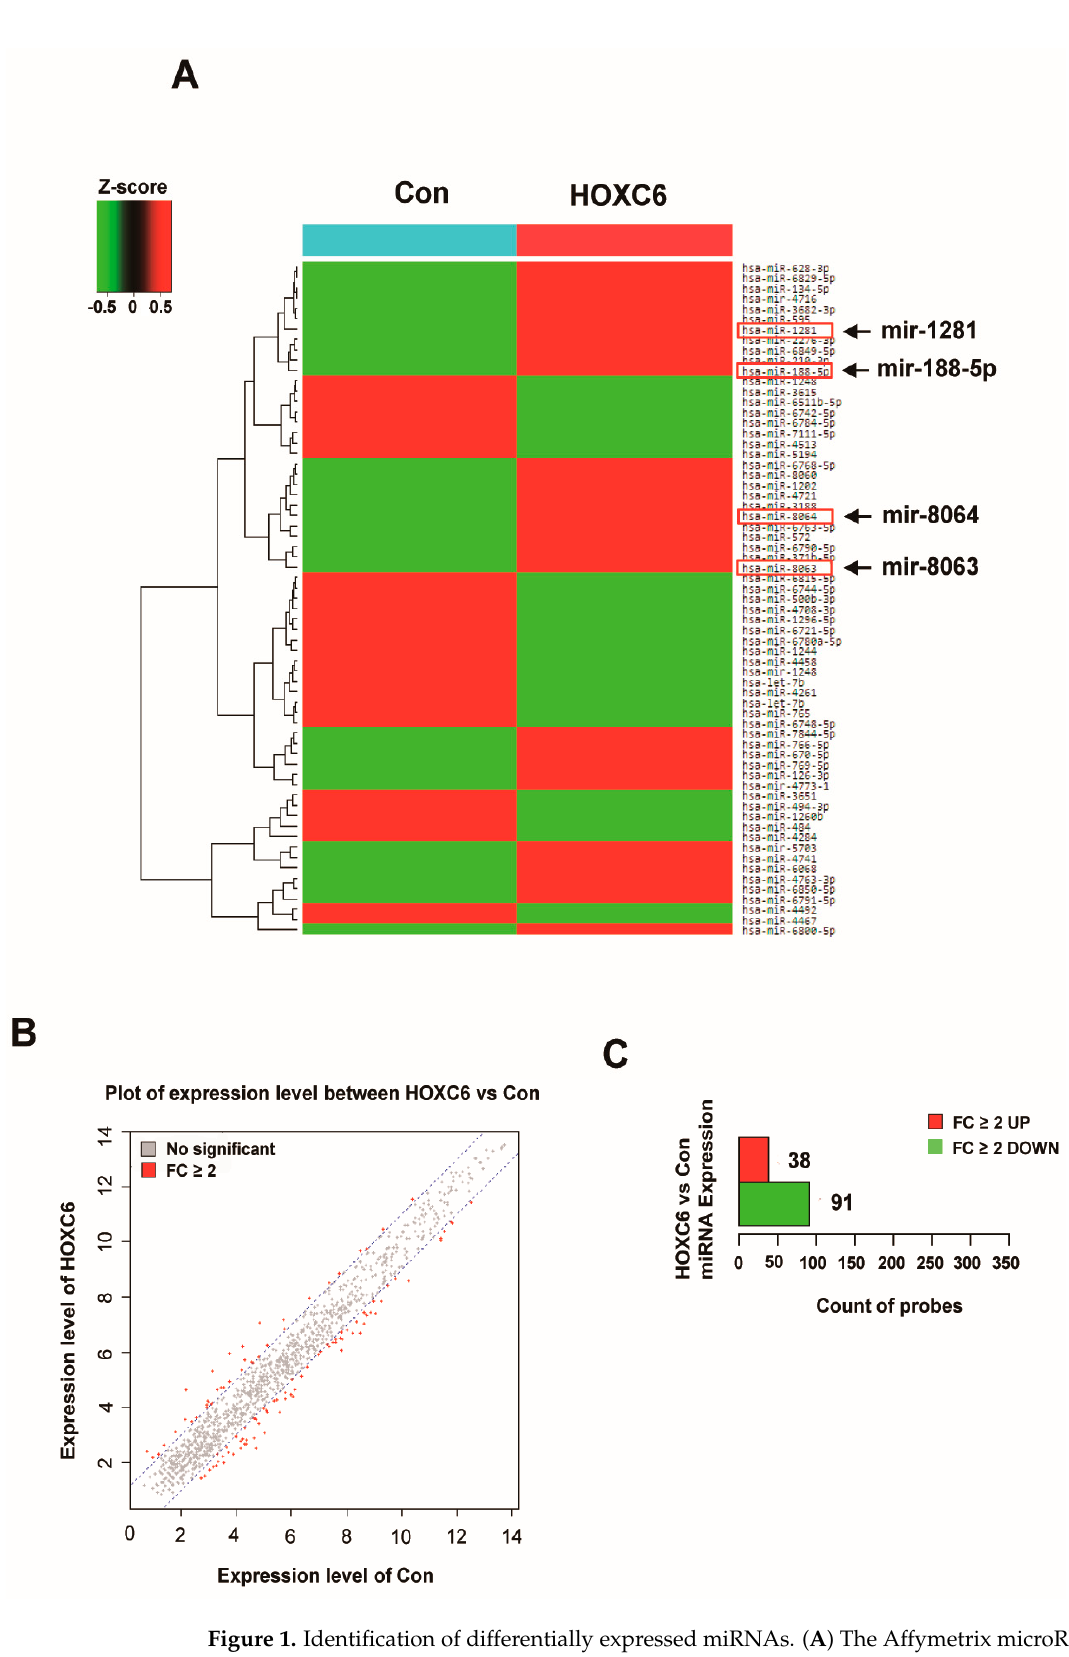
Figure 1. Identification of differentially expressed miRNAs. ( A ) The Affymetrix microRNA microar- ray revealed differential miRNA expression profiles in FaDu cells vs. HOXC6-expressing FaDu cells. ( B ) Differentially expressed microRNAs in a scatter plot analysis. ( C ) Bar plot of significantly different miRNAs. The bar plot shows the most strongly deregulated miRNAs in comparison between the FaDu/HOXC6 cells and the control